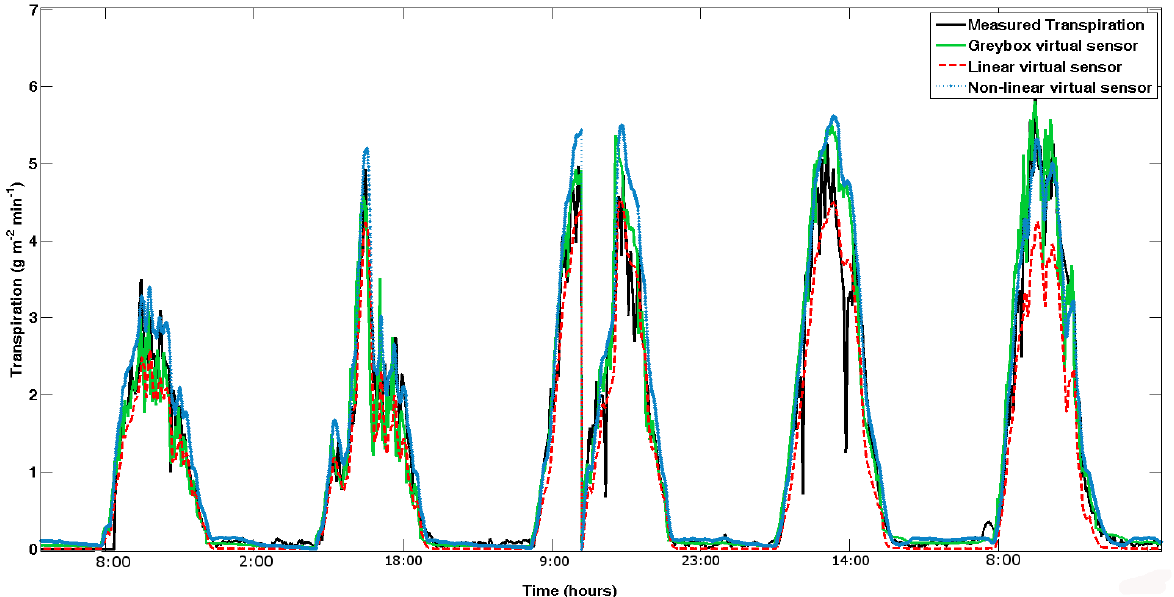
Figure 9. Five days in 2005 spring.